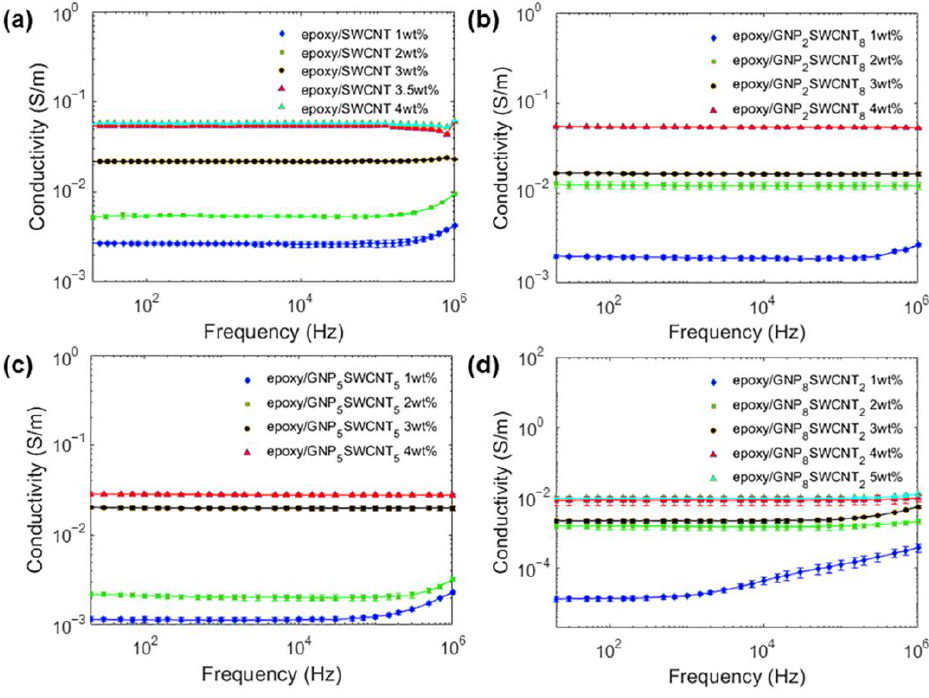
Figure 3. Electrical conductivity of ( a ) epoxy/SWCNT, ( b ) epoxy/GNP 2 SWCNT 8 , ( c ) epoxy/GNP 5 SWCNT 5 and ( d ) epoxy/GNP 8 SWCNT 2 nanocomposites with different filler loadings after cure.